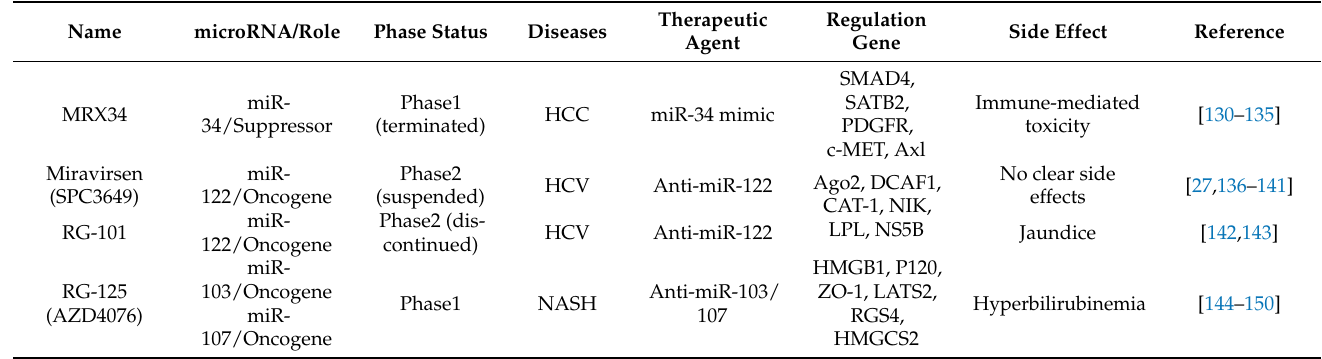
Table 1. MiRNA-based clinical drugs for